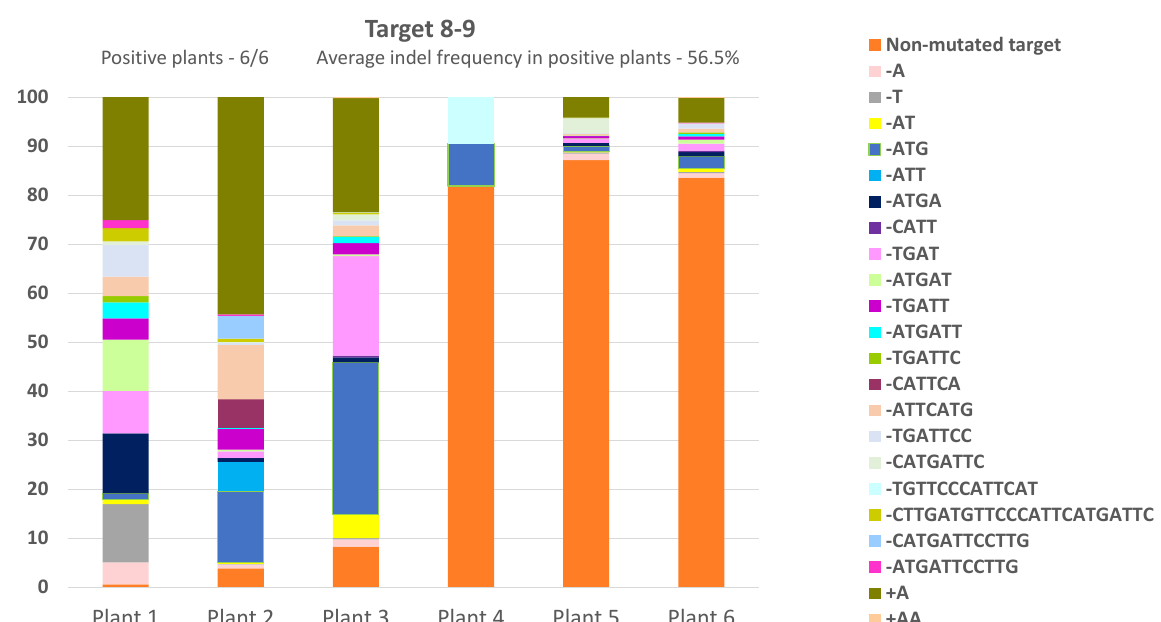
Figure 3. NHEJ frequency in F 1 plants of CRTISO assay DSB target 8–9. Illumina NextSeq high-throughput sequencing results for F 1 plants analyzed using NGS Cas-Analyzer and presented for CRTISO assay DSB target 8–9. Six F 1 plants were analyzed. The indels frequency was calculated by the number of indel reads out of the total number of reads (including non-mutated target footprint) and shown as a percentage. No indels were detected in three control plants with Cas9 only.